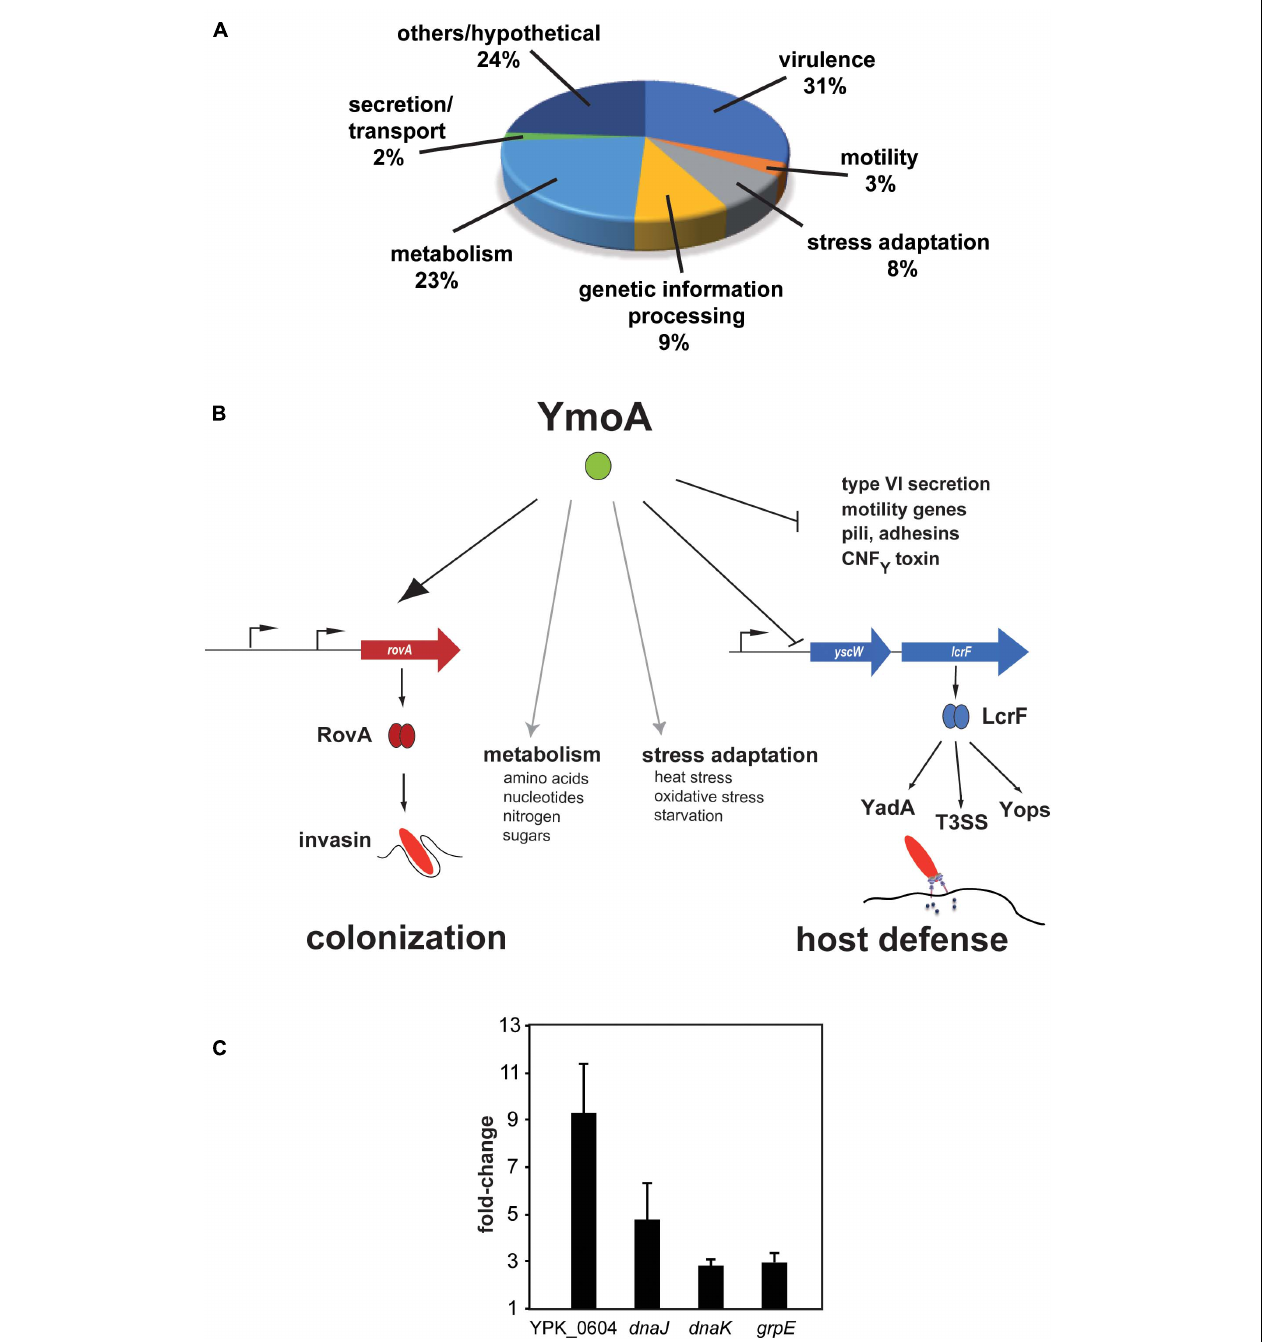
FIGURE 1 | Influence of YmoA on the global gene expression in Y. pseudotuberculosis. (A) Proportion of gene classes up- or downregulated by YmoA. Genes showing overall fold-changes ≥ 2.0 are included in the displayed diagram of gene classes. (B) Schematic scheme of the global influence of YmoA on virulence-relevant genes. YmoA activates the synthesis of the early-phase virulence RovA, leading to expression of colonization factors such as invasin. In contrast, later-stage virulence factors, e.g., YadA, Yops, or T3SS, which are essential to combat triggered immune responses, are silenced by YmoA through repression of the transcriptional activator LcrF. Moreover, YmoA is implicated in many other virulence-relevant metabolic and stress adaptation processes. This control network allows switching of virulence gene expression by variations of YmoA levels. The dark arrow displays activation of the gene expression or protein synthesis; T represents repression or inactivation. Gray arrows indicate control of metabolic and stress adaptation processes by YmoA. (C) RNA of early stationary cultures of strains YPIII and YP50 ( (cid:49) ymoA ) in LB medium at 25 ◦ C was prepared and six independent samples were pooled. qRT-PCR was carried out in triplicates. Gene expression levels were normalized to levels of the sopB transcript and are given as relative values (cid:49) ymoA /wild-type. Mean ± SD of three independent experiments are displayed.